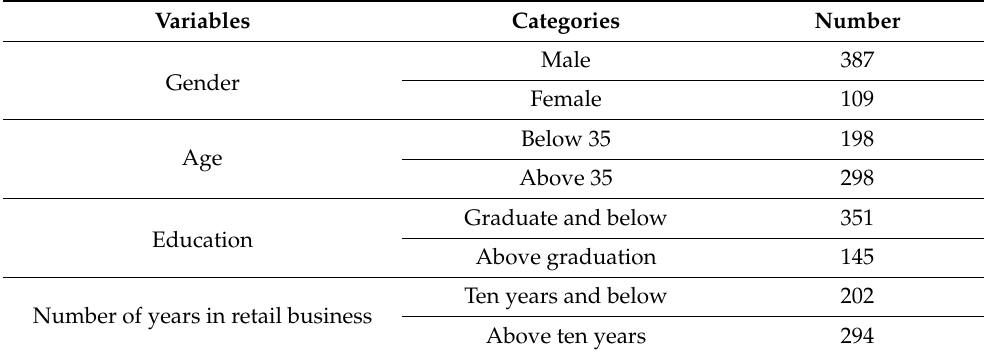
Table 1. Participants’ demographic